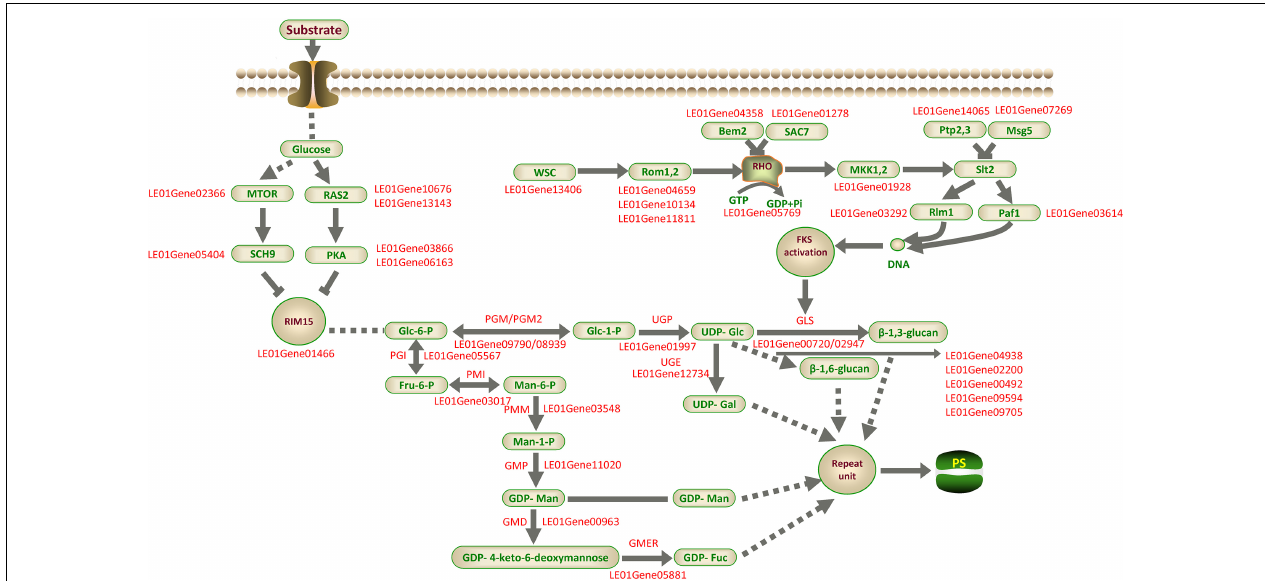
FIGURE 11 | Putative model of LEFP30 biosynthesis in L. edodes . The supported and unsupported paths are represented by solid arrows and dashed arrows, respectively. MTOR, Serine/threonine-protein kinase tor2; RAS2, Ras-like protein; SCH9, Serine/threonine-protein kinase SCH9; PKA, cAMP-dependent protein kinase type 1; RIM15, Serine/threonine-protein kinase cek1; PGI, Phosphoglucose isomerase; PMI, Phosphomannose isomerase; PMM, Phosphomannose mutase; GMP, GDP-Man pyrophosphorylase; GMD, GDP-Man dehydratase; GMER, GDP-4-keto-6-deoxymannose epimerase/reductase; PGM/PGM2, Phosphoglucose mutase; UGP, UDP-Glc pyrophosphorylase; UGE, UDP-Gal-4-epimerase; SAC7, Rho-GTPase-activating protein; MAK1,2, MAP kinase kinase; Rlm1, Serum response factor homolog A; Paf1, RNA polymerase II-associated protein; Rom1,2, Rho1 guanine nucleotide exchange factor; RHO, GTP-binding protein; Msg5, Dual specificity protein phosphatase; Ptp2,3, Receptor-type tyrosine-protein phosphatase; Bem2, Beta-chimaerin; GLS, β -1,3-glucan synthase; SMI1/KNR4, Glucan synthesis regulatory protein; Gas1p, β -1,3-glucanosyltransferase; PS,